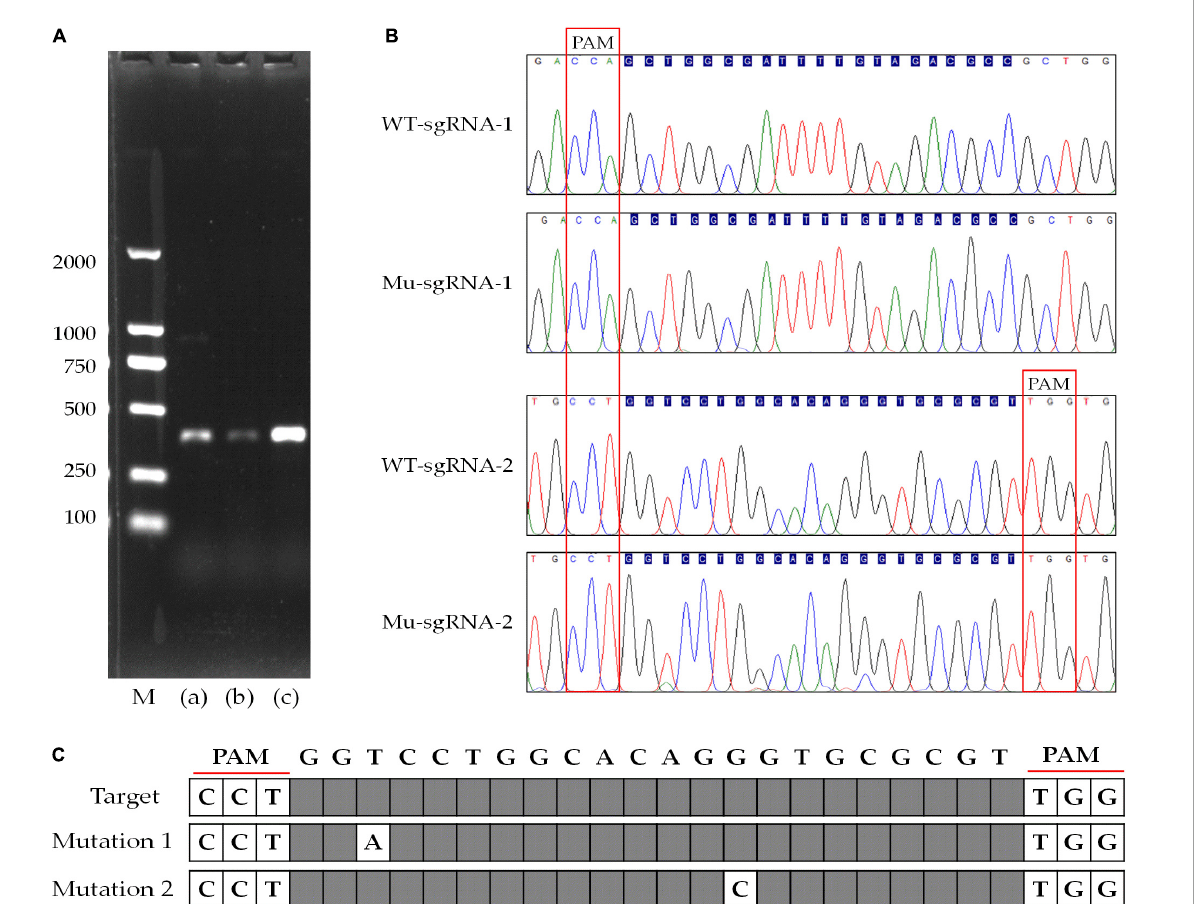
FIGURE6 Disruption of the gene targeting to ura3 by CRISPR-Cas9 system with different sgRNA target sites. (A) Agarose gel electrophoresis of PCR products of ura3 in wild-type and mutant strain; (B) sequencing chromatogram of the Ura3-sgRNA1 and Ura3-sgRNA2 target region; (C) the display of the mutated site at Ura3-sgRNA2 target region; M, DNA ladder 2000 Marker; (a) sgRNA-1 target site of ura3 ; (b) sgRNA-2 target site of ura3 ; and (c) wild type of ura3 including sgRNA-1 and